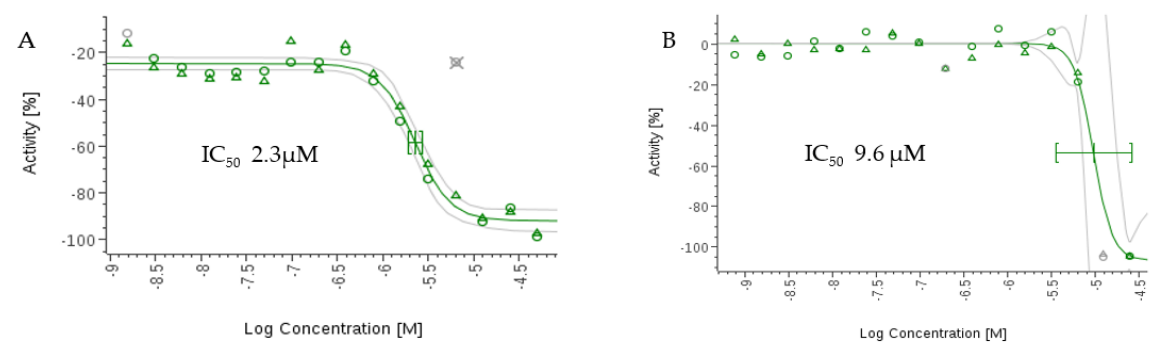
Figure 8. ( A ) Dose − dependent IC 50 curve of 1 for P. falciparum 3D7. ( B ) Dose − dependent IC 50 curve of 1 for T. cruzi Tulahuen.